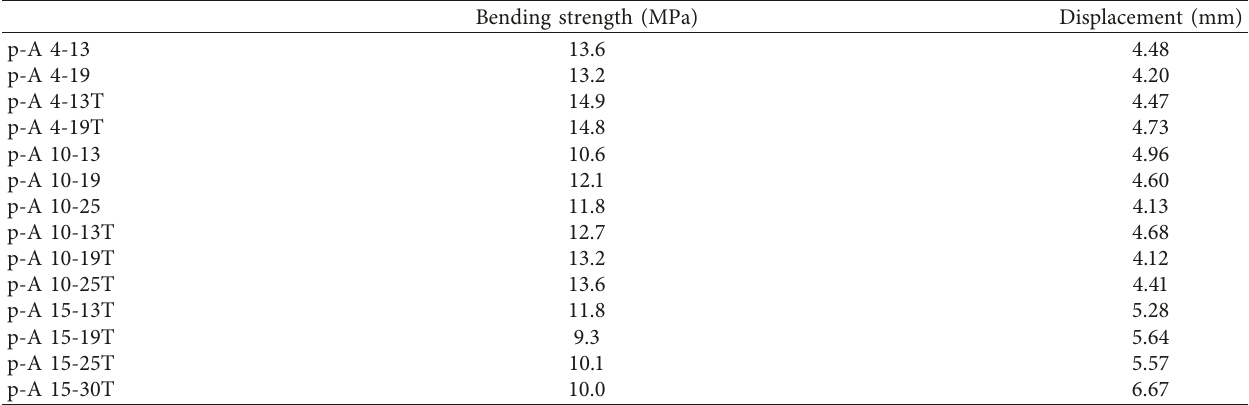
Table 14: Bending test